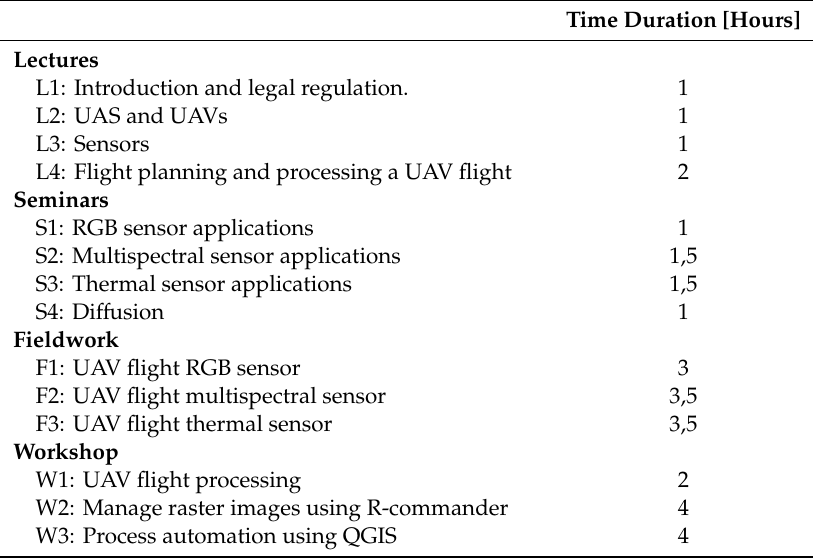
Table 3. Type and duration of teacher-guided activities for “UAVs in the Agroforest